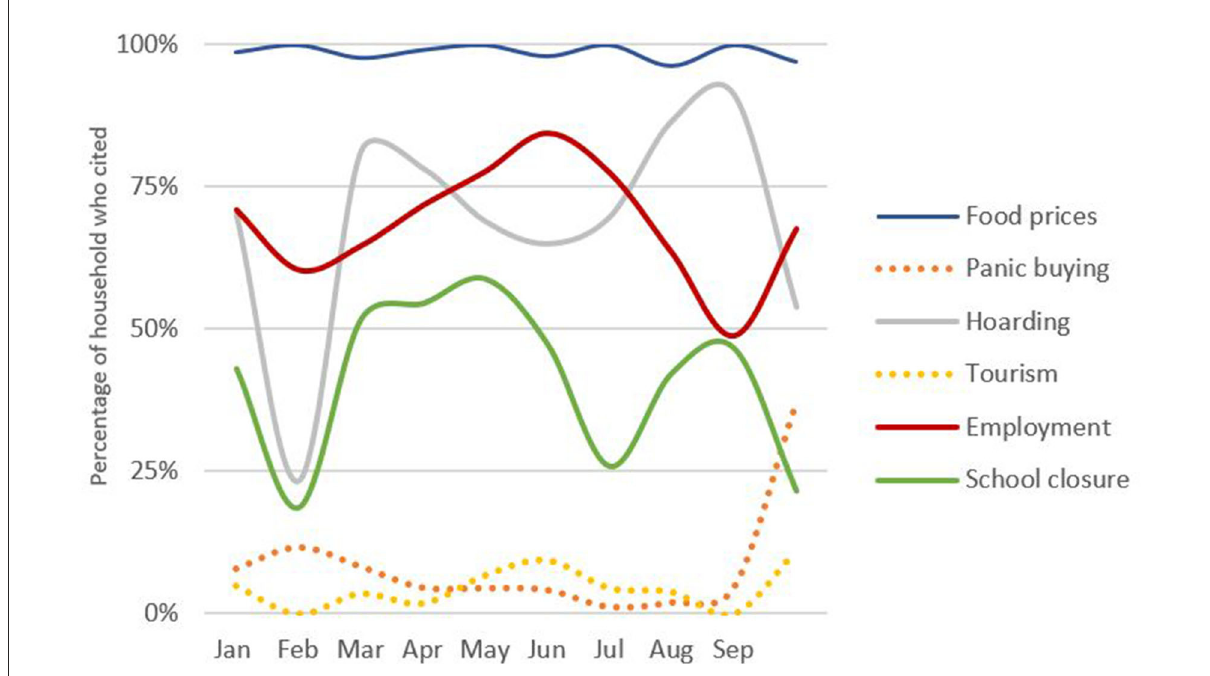
FIGURE2 Perceived Covid impacts by month (Own graph, data source Survey